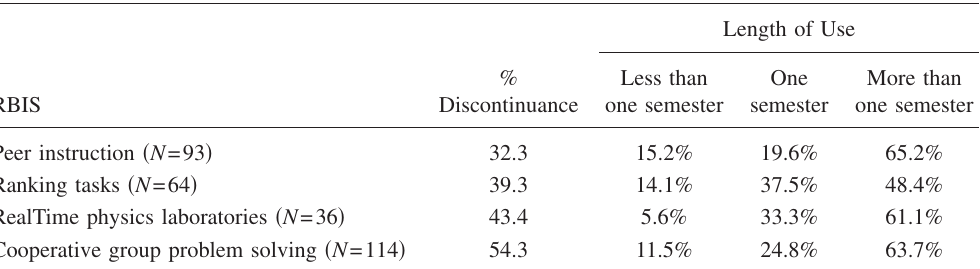
TABLE IX. Ranking of 4 RBIS according to percentage of faculty who have discontinued use as well as length of use (cid:1) prior to discontinuation (cid:2) . Discontinuance of a RBIS is calculated by dividing the number of former users by the number of former plus current